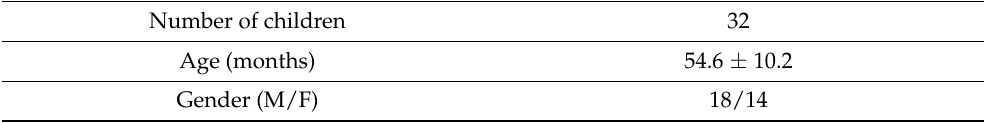
Table 1. The demographic data of the